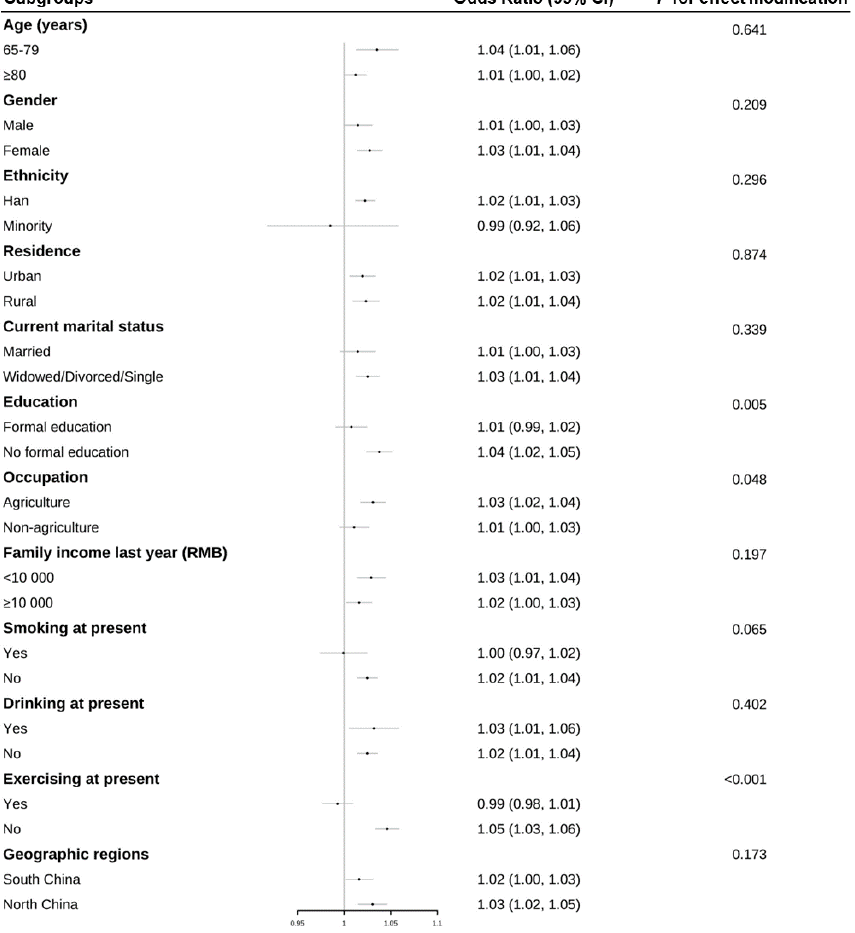
Figure 2. Subgroup analysis for the associations between each 1 °C decrease of average temperature in January and frailty.